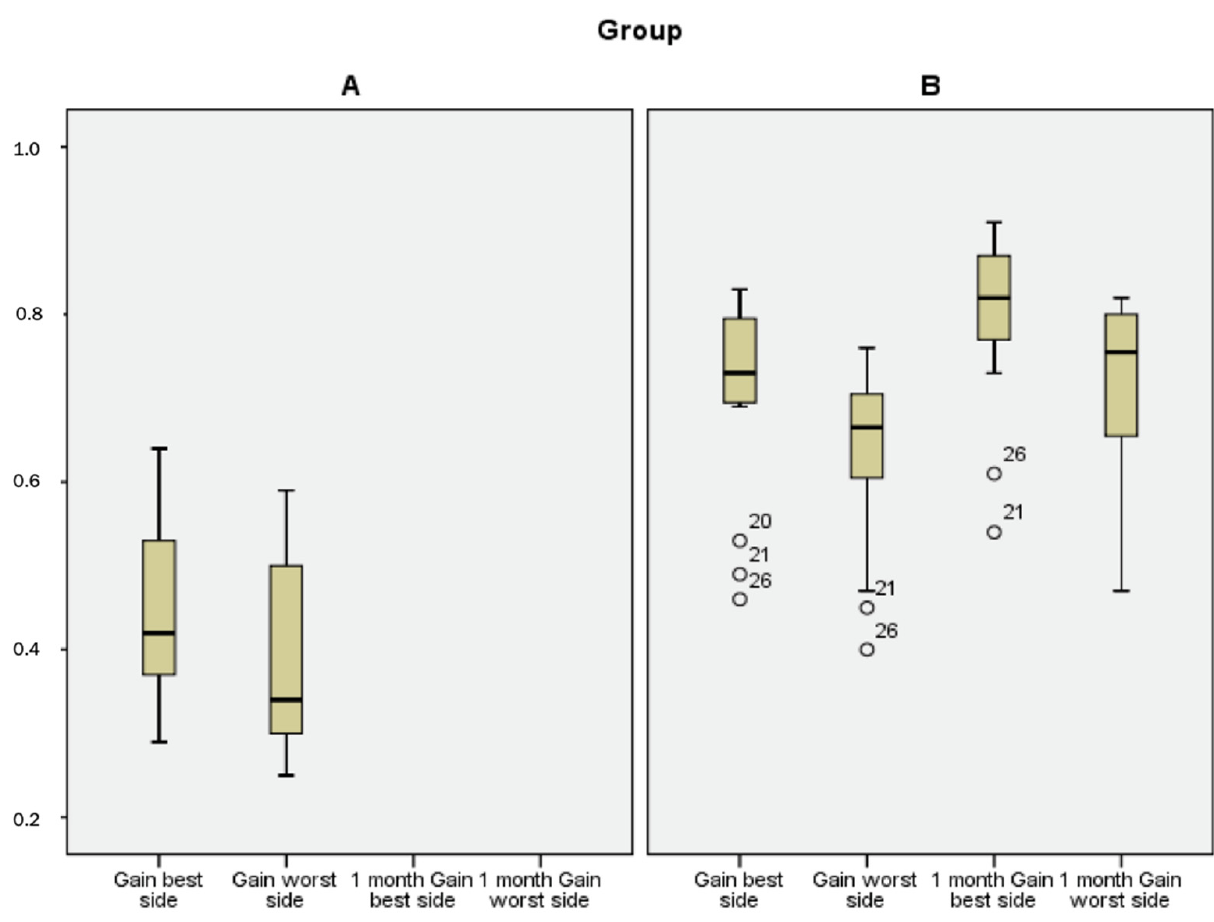
Figure 1. Box plot of the gains to the best or the worst side in each group of patients. ( A ): Group A at the first evaluation. ( B ): Group B at the first evaluation and after 1 month.